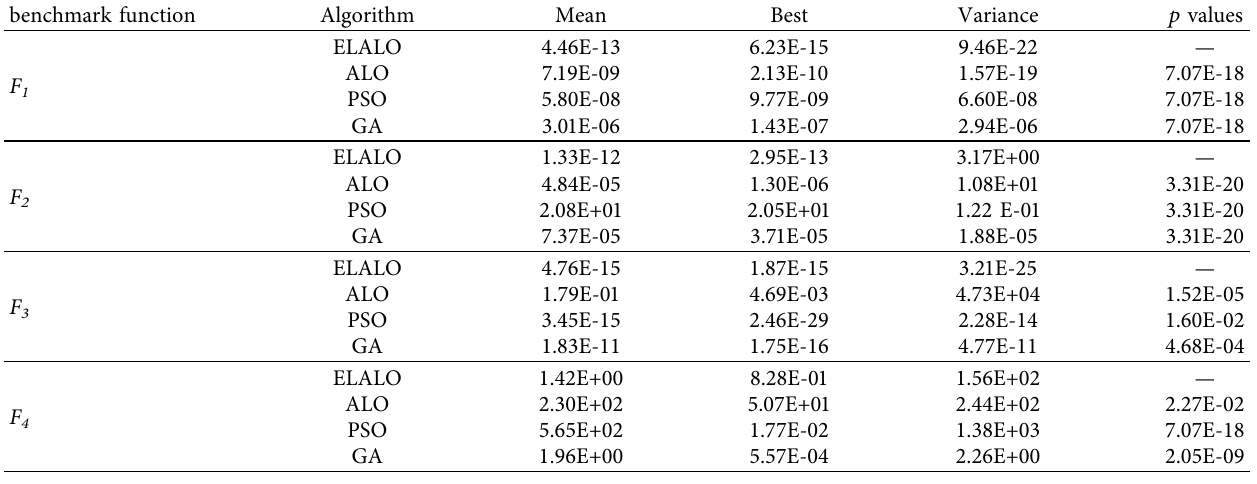
Table 2: Comparison results in four benchmark